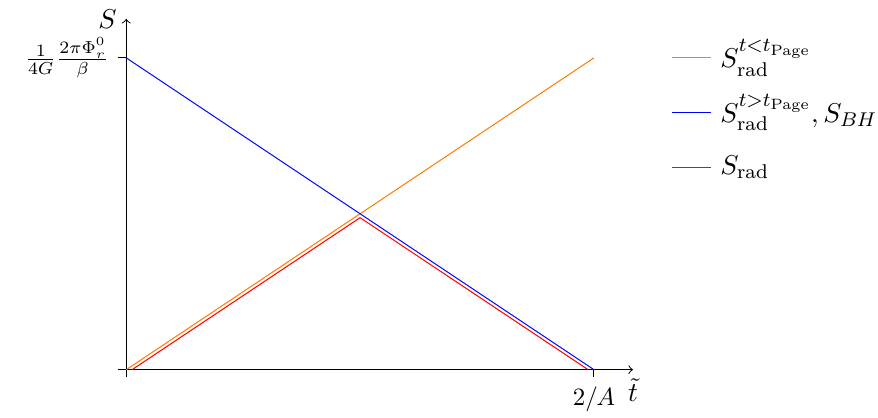
Figure 4. The entropy of the radiation follows a Page curve (red